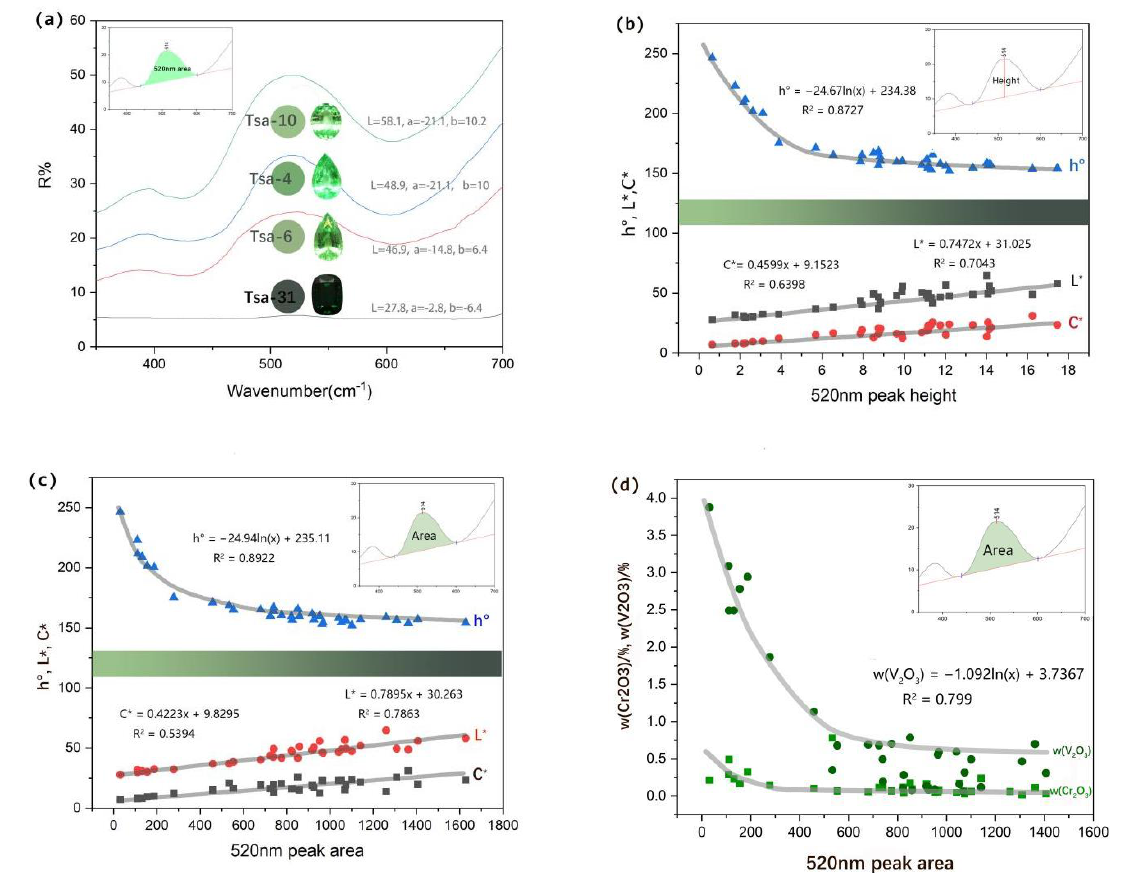
Figure 7. ( a ) The 520 nm peak changes with samples with different hues (R% = Reflectance%); ( b ) the changes of L*, C*, h ◦ with the increase of 520 nm peak height; ( c ) the changes of L*, C*, h ◦ with the increase of 520 nm peak area; ( d ) the changes of w(V 2 O 3 ) and w(Cr 2 O 3 ) with the increase of 520 nm peak area.